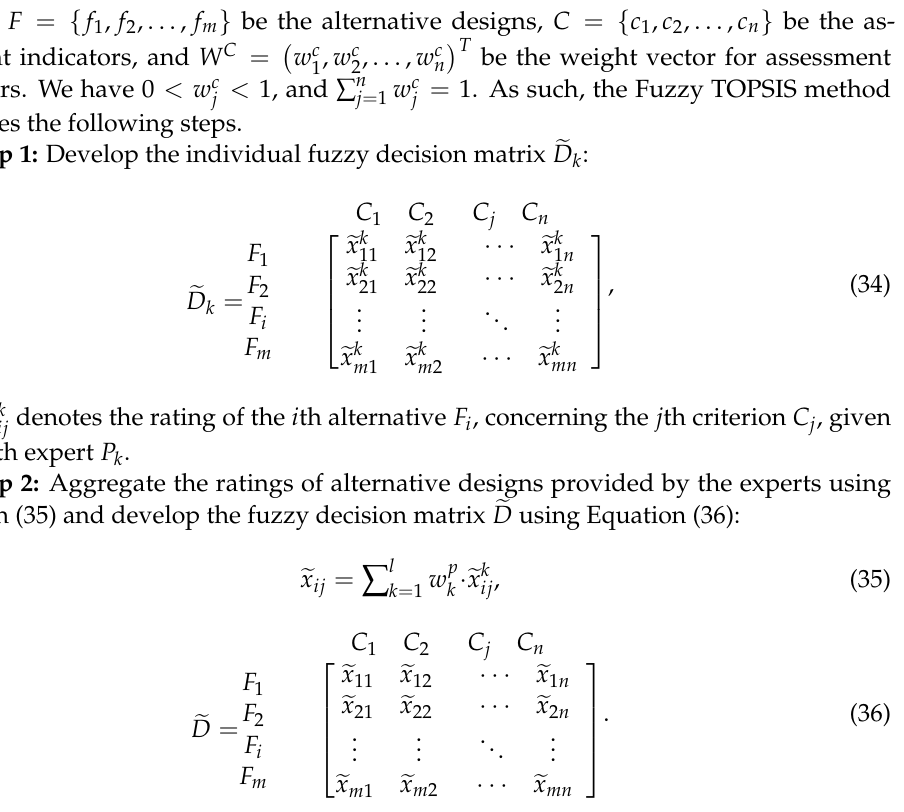
Figure 7. Linguistic scales for rating the criteria performances. Table 4. Linguistic terms and corresponding TFN s.